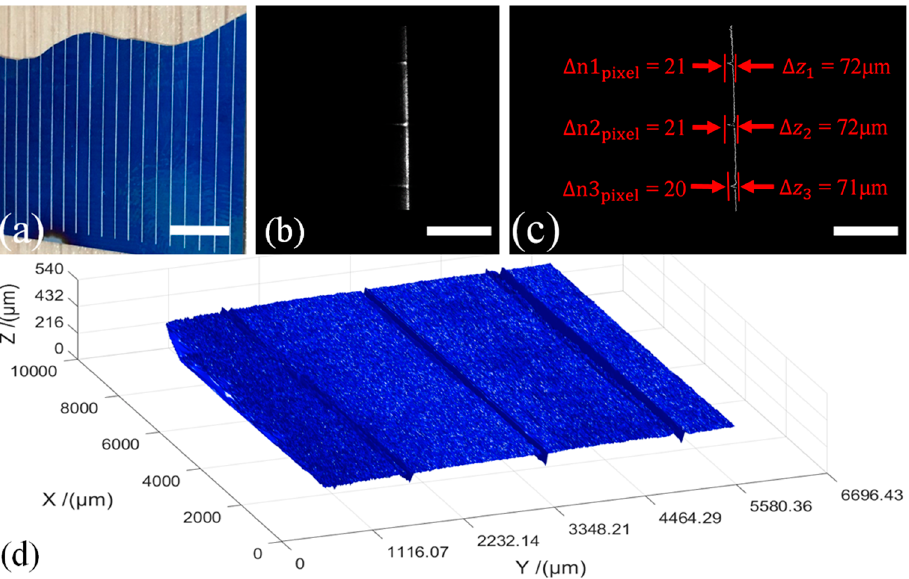
Figure 8. Surface topography inspection of a solar cell panel. ( a ) The solar cell panel used in the experiment. Gate lines are the white lines. Scale bar: 6 mm. ( b ) Light-sheet modulated by the gate lines. Scale bar: 1 mm. ( c ) Measured contoured image. Scale bar: 1 mm. ( d ) Calculated 3D surface topography of the solar cell panel.